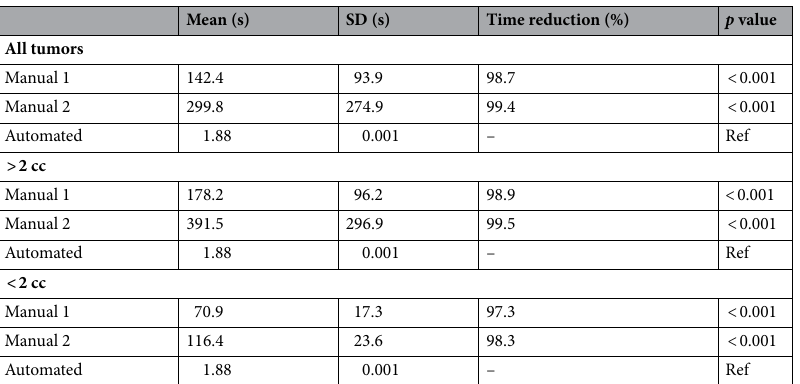
Table 2. Manual versus automated tumor segmentation times. Comparison between the average time needed by experts (Manual 1 and Manual 2) and our algorithm (Automated) to produce high-quality tumor segmentations. The algorithm saved 98% of time on average and the difference between the algorithm and each expert in each tumor group reached significance ( p < 0.001). s: seconds, ref : reference.